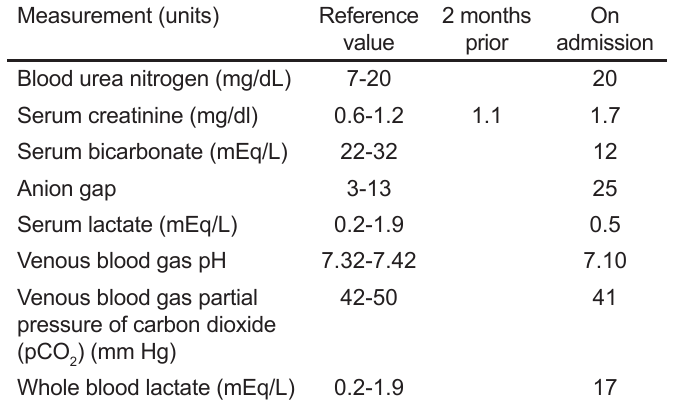
Table. Laboratory values in patient who presented with altered mental